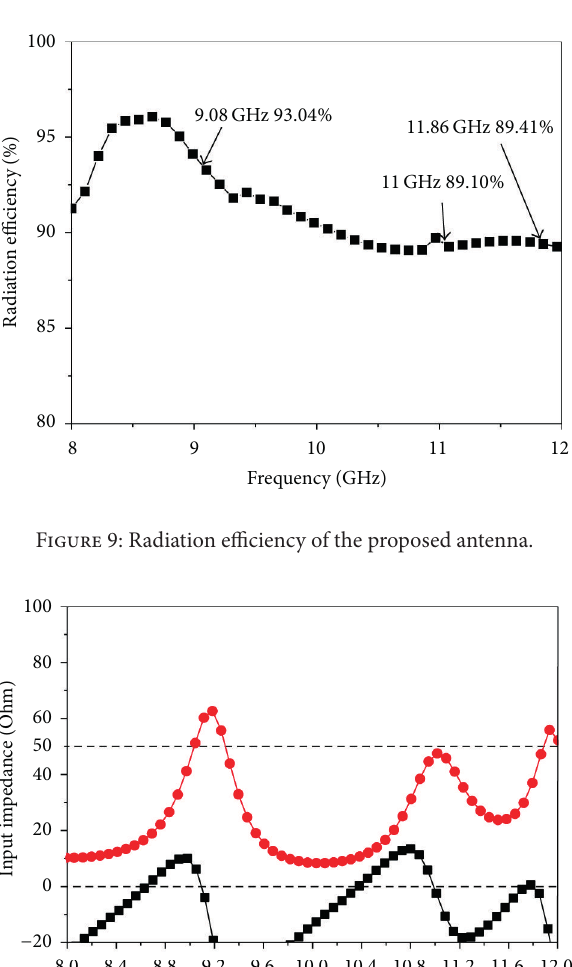
has attempted to be as close as possible to 50 Ohms in the desired three bands. On the other hand, the imaginary part of the impedance has tried to be as close as possible to